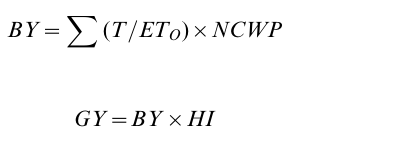
winter wheat under different planting dates in 2008/2009, 2009/2010, 2010/2011 and 2011/2012. Planting